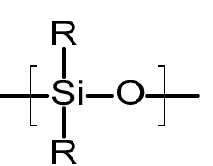
Figure 5. An illustration of the chemical structure of poly(siloxane).